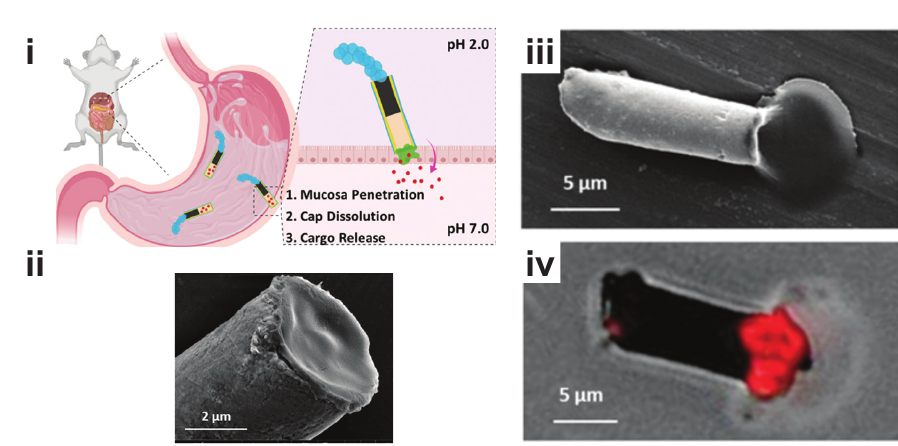
Figure 4. Microbiorobots can penetrate physical barriers in organ-on-a-chip systems. ( A ) Tissue surfaces vary in their di ff usive permeability and must be penetrated for drugs to reach their